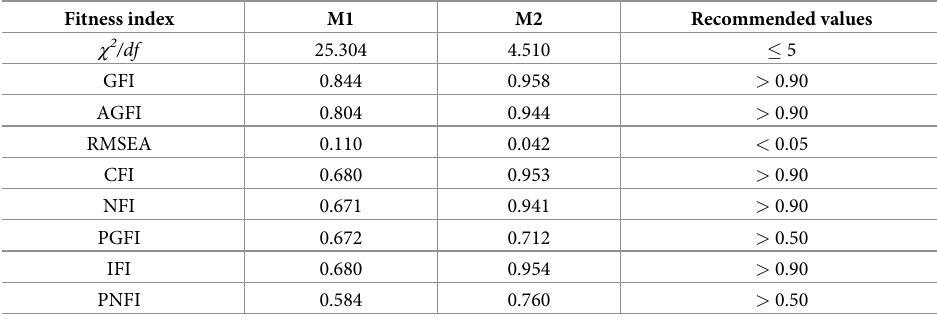
Table 3. Summary of model fitness index.